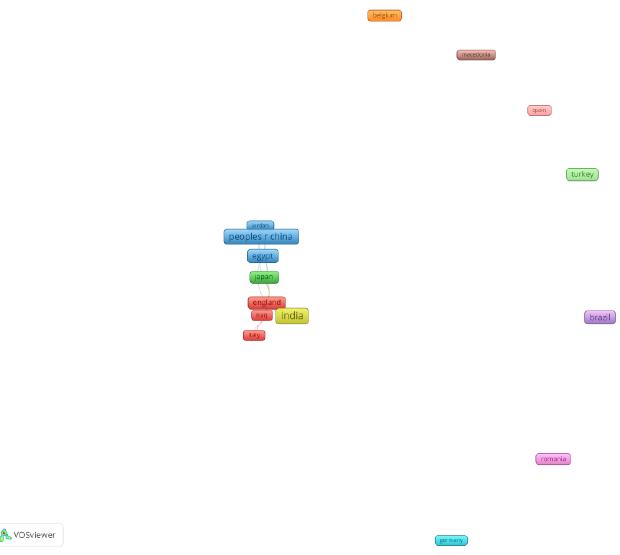
Figure 3. Scientific co-authorship by country. Source: own processing through VOSviewer.